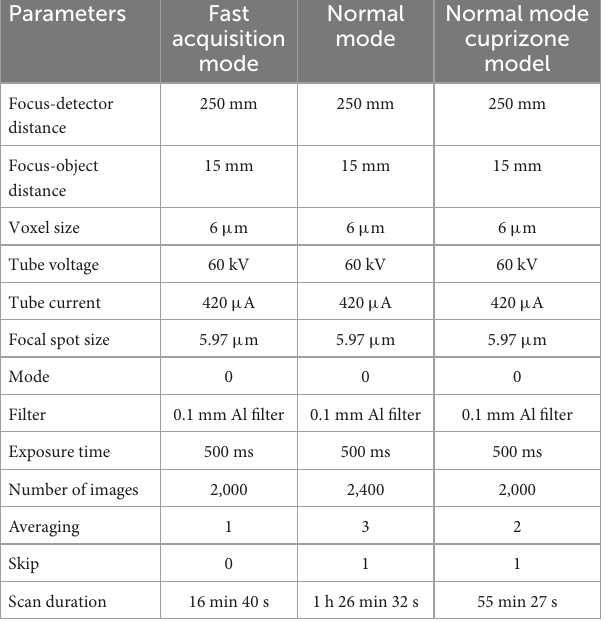
TABLE 2 Overview of acquisition parameters. Parameters Fast